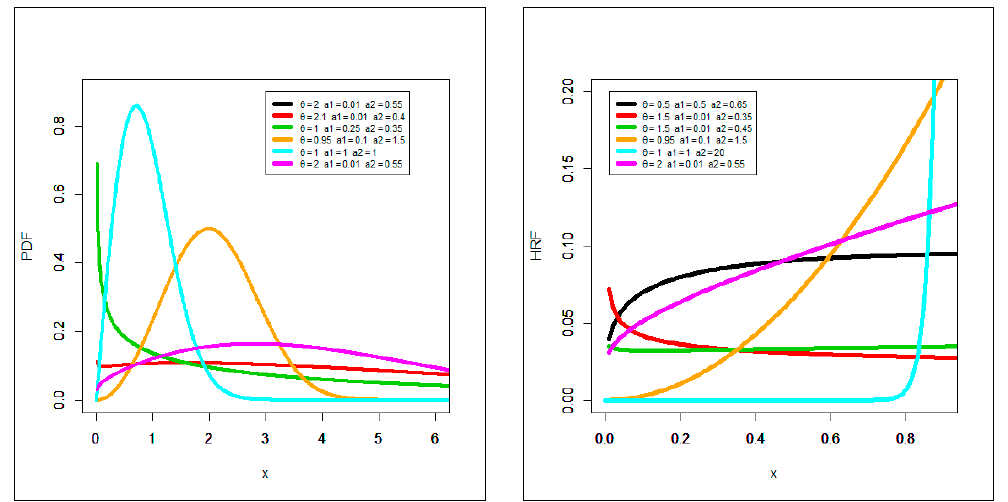
Figure 1. Plots of probability density function (PDF) and hazard rate function (HRF) for the Rayleigh generalized log-logistic (RG-LL) model.